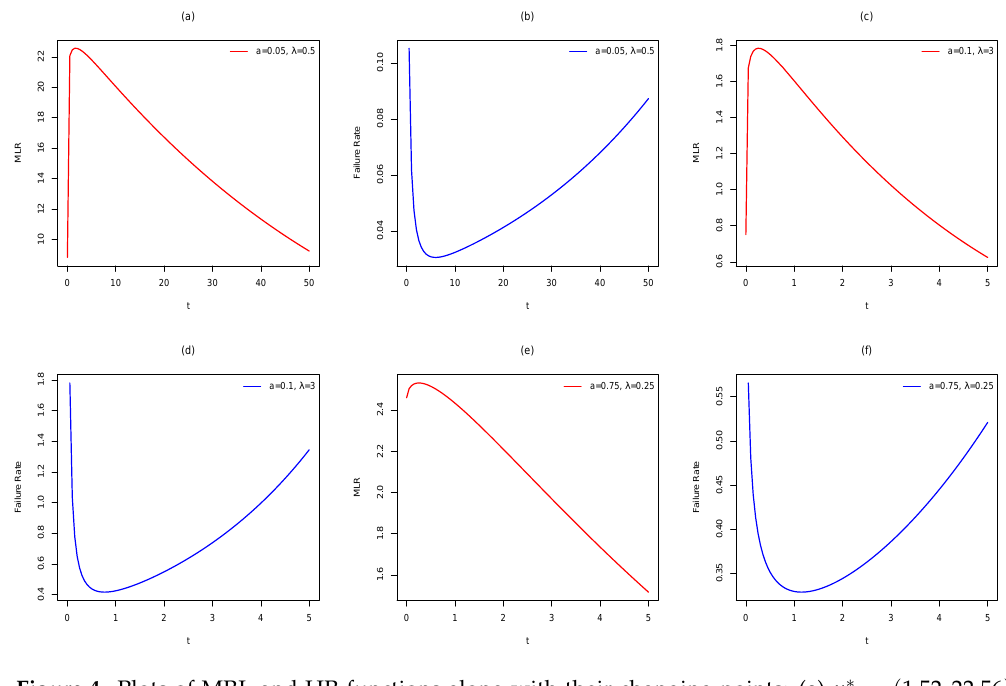
Figure 4. Plots of MRL and HR functions along with their changing points: ( a ) µ ∗ = ( 1.52,22.56 ) ; ( b ) t ∗ = ( 6.06,.03 ) ; ( c ) µ ∗ = ( 0.25,1.78 ) ; ( d ) t ∗ = ( 0.75,0.42 ) ; ( e ) µ ∗ = ( 0.3,2.53 ) ; ( f ) t ∗ = ( 1.16,0.33 )